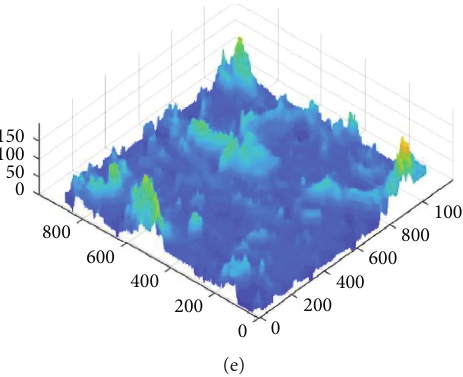
Figure 4: Three-dimensional structural characteristics of soil sample: (a) 500 times magnification, (b) 1000 times magnification, (c) 3000 times magnification, (d) 5000 times magnification, (e) and 10,000 times magnification.